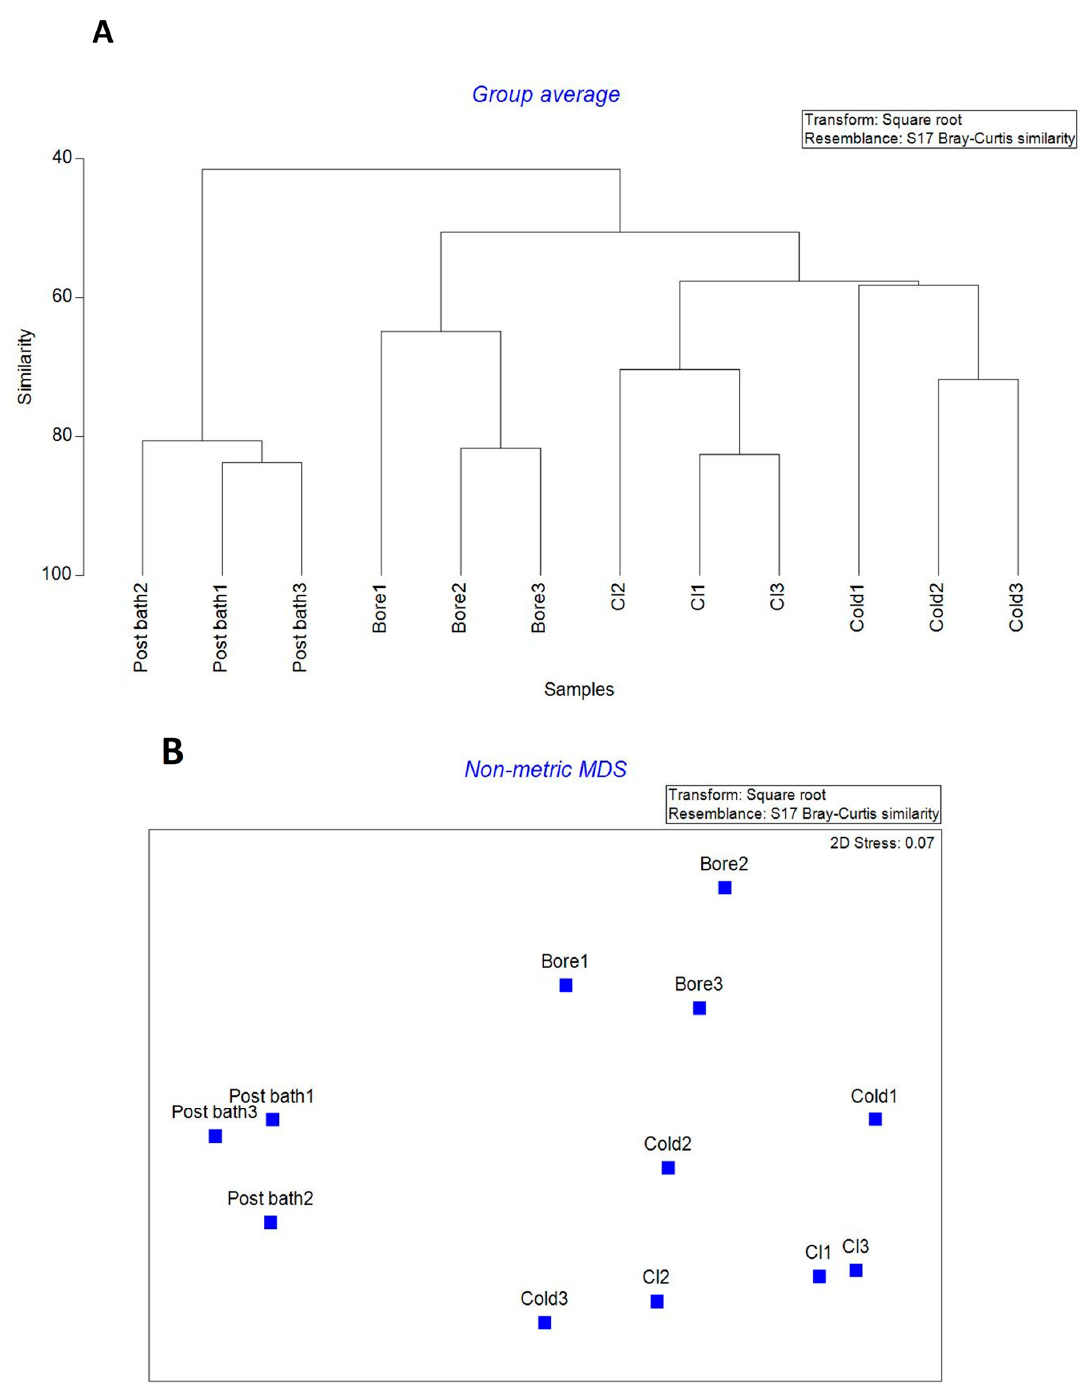
Figure 3. ( A ) Bray Curtis similarity resemblance measure applied to samples from PHS. ( B ) Non-metric multidimensional scaling (NMDS) was performed using Primer 7. multidimensional scaling (NMDS) was performed using Primer 7. Data from this study was subjected to XLSTAt (2014) for Principal component analysis with a Pearson (n) coe ffi